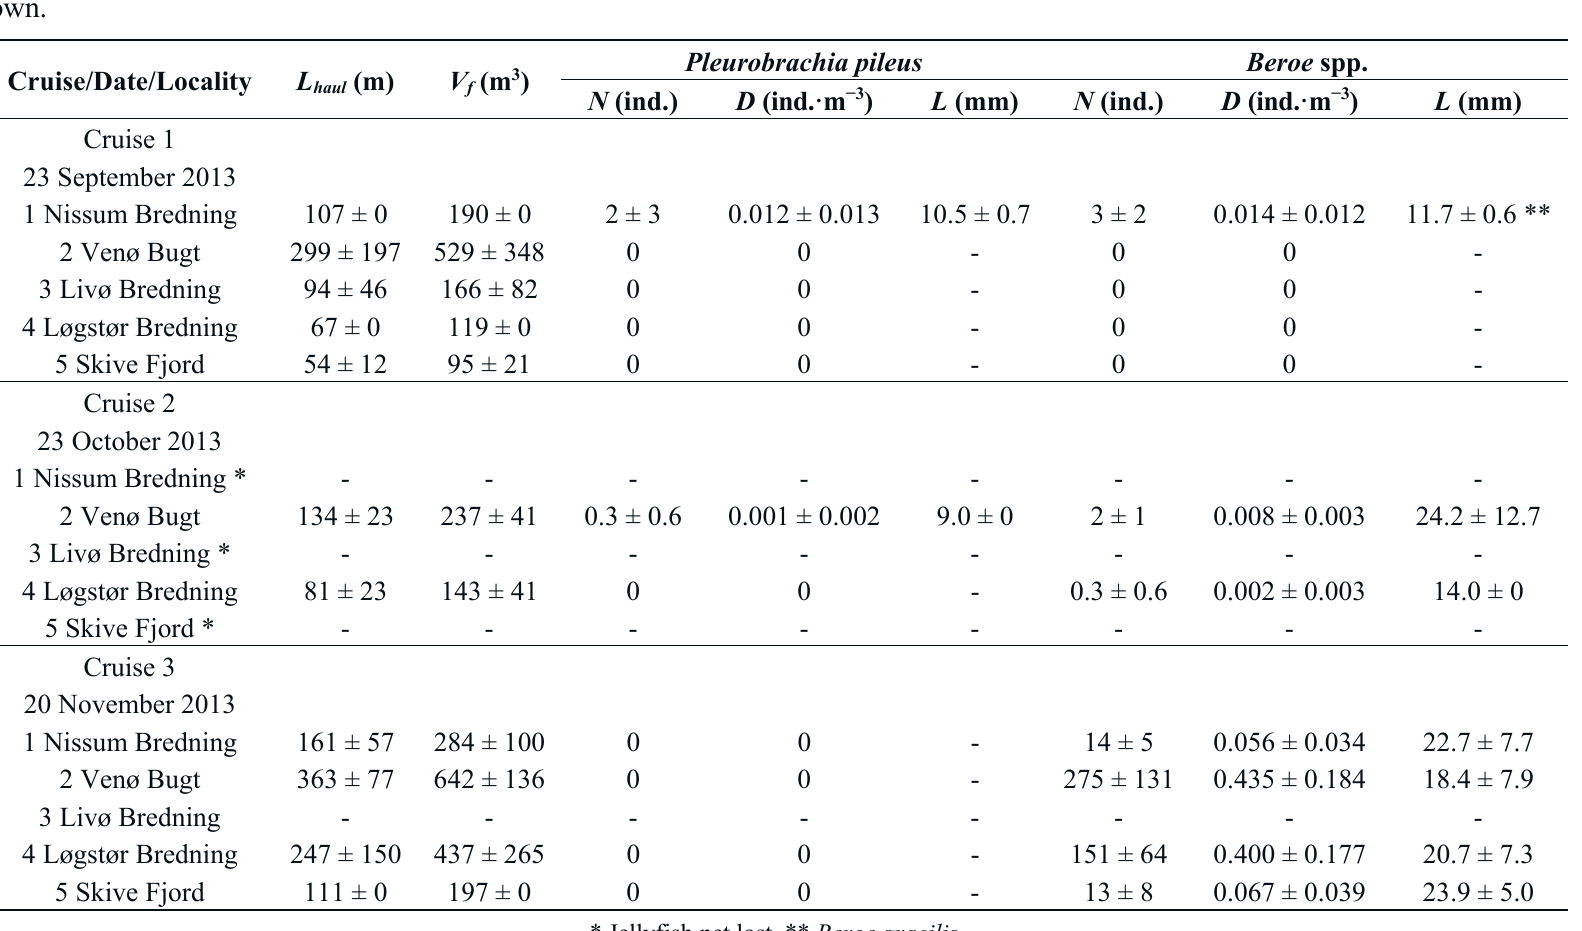
Table 5. Other ctenophore species than Mnemiopsis leidyi ( cf. Table 4) collected during three cruises in Limfjorden in 2013. L haul = haul length; V f = volume filtered per haul; N = total number of individuals caught; D = population density; L = oral–aboral body length. Mean ± SD are